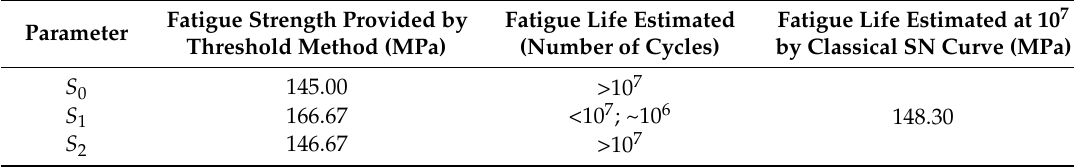
Table 6. Fatigue life estimations by using the stress provided by the threshold method.